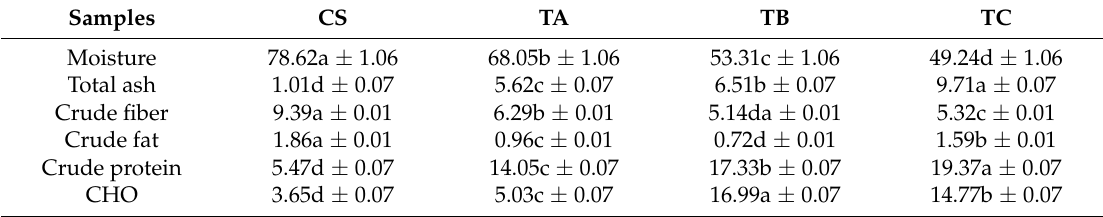
Table 2. Nutritional composition (%) of smoothies supplemented with Moringa oleifera leaves.